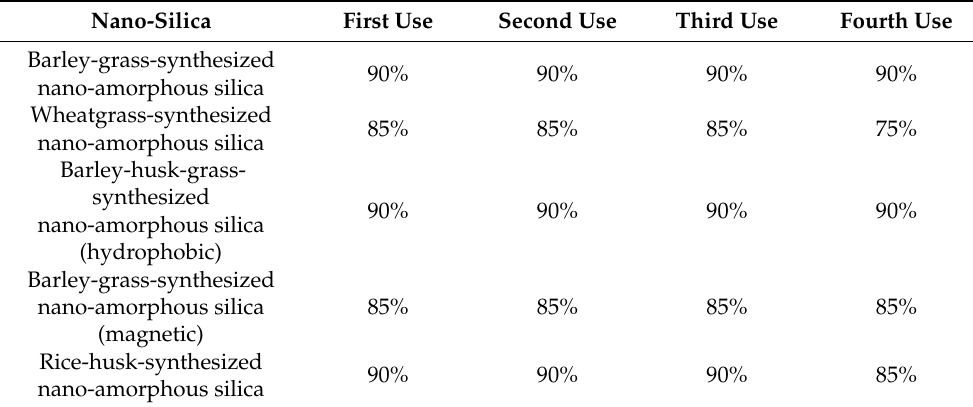
Table 4. Reusability results of nanoparticles from different